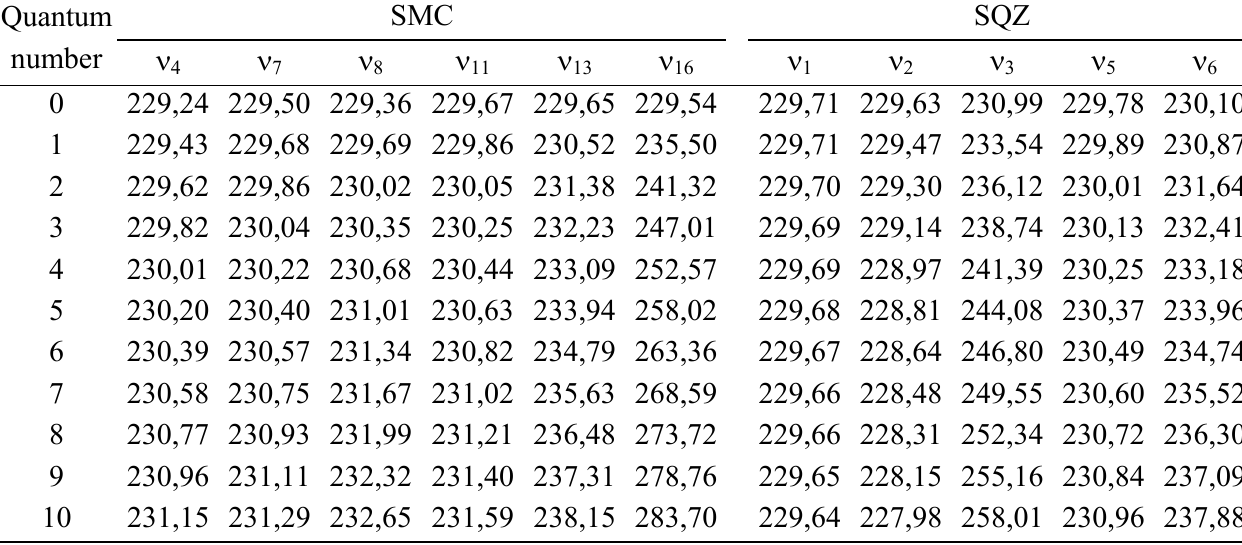
Table 5. Energy splittings (cm -1 ) calculated for two-dimensional model potentials.